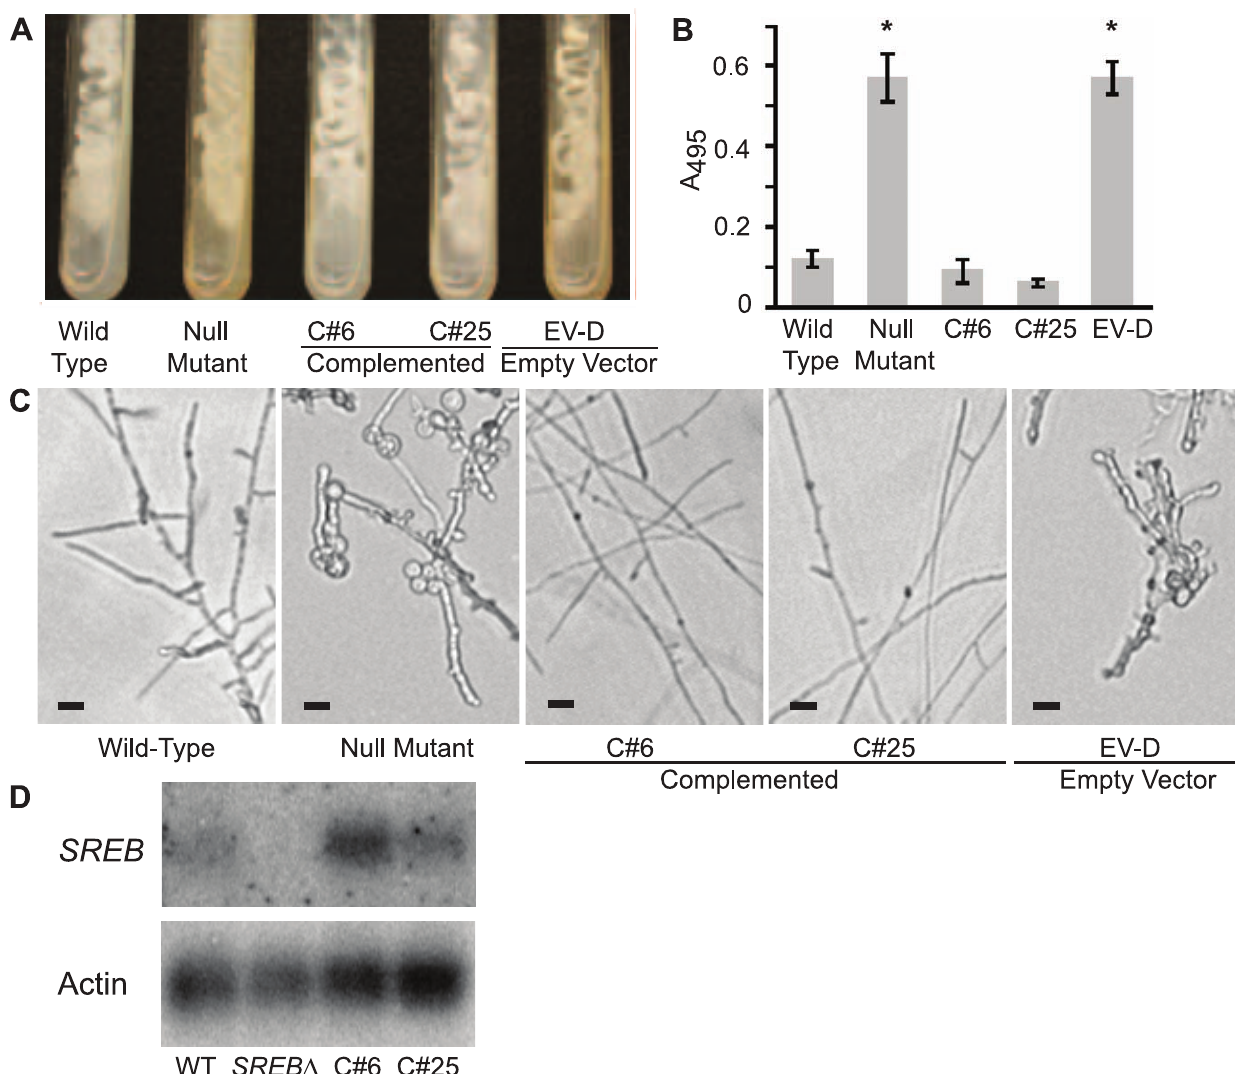
Figure 5. Complementation of the SREB null mutant. ( A ) Complemented strains C # 6 and C # 25 grew as white-colored yeast, similar to the wild-type isolate, on 7H10 slants (150 m M FeSO 4 ). In contrast, the null mutant ( SREB D ) and empty vector strain EV-D grew as yellow-colored yeast and discolored the medium. Cultures were grown at 37 u C for 14 days. ( B ) Complemented strains C # 6 and C # 25 were able to repress the biosynthesis of siderophores when grown-under iron-replete (10 m M FeSO 4 ) conditions as measured by the ferric perchlorate assay. In contrast, the null mutant and empty vector (EV-D) continued to produce siderophores (p , 0.01). Data from three independent experiments were analyzed. ( C ) Wild-type and complemented strains C # 6 and C # 25 convert to mycelia within 17 days of incubation at 22 u C. In contrast, the null mutant and empty vector EV-D strains fail to complete the conversion to mycelia. ( D ) Northern blot hybridization demonstrated restoration of SREB transcript abundance in complemented strains C # 6 and C # 25, when compared to the null